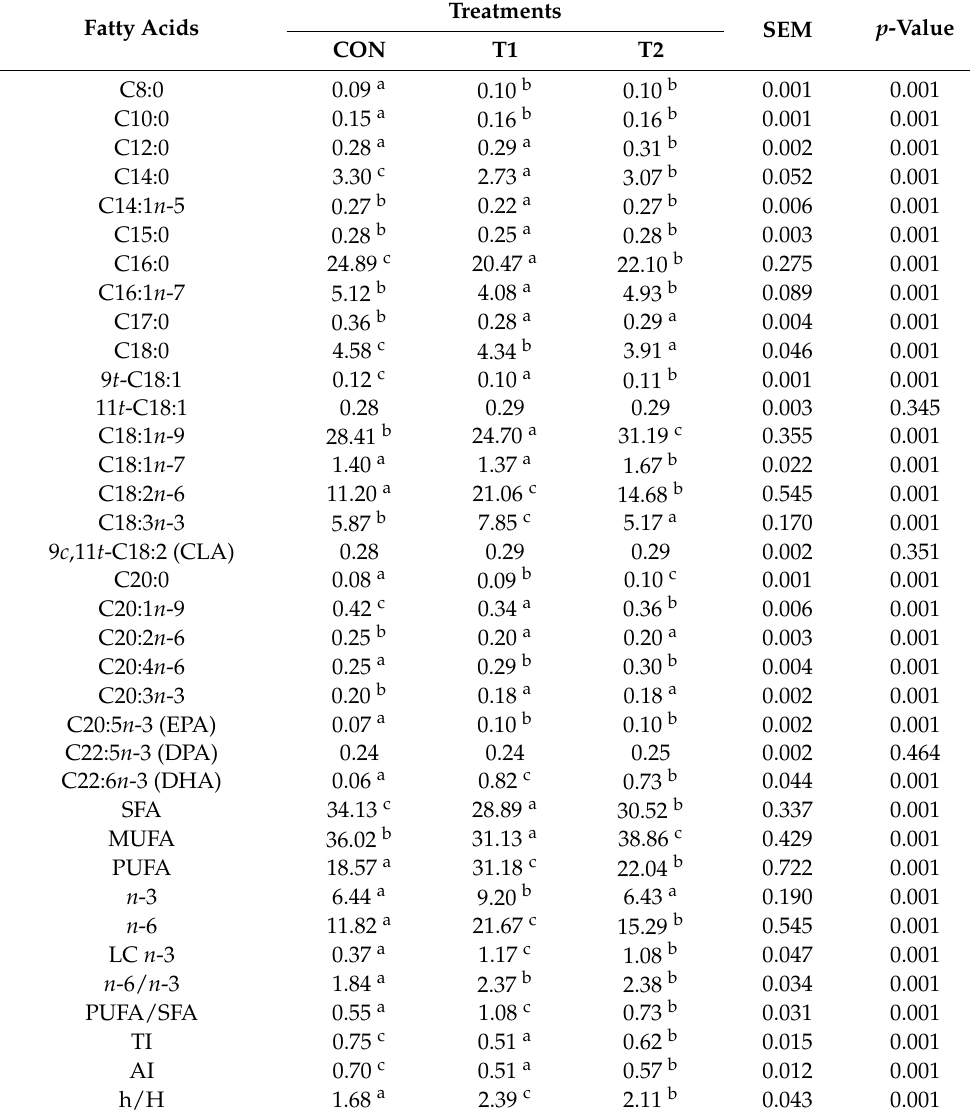
Table 4. Fatty acid compositions (expressed as g/100 g of fat) of the foal p â t é s. Fatty Acids